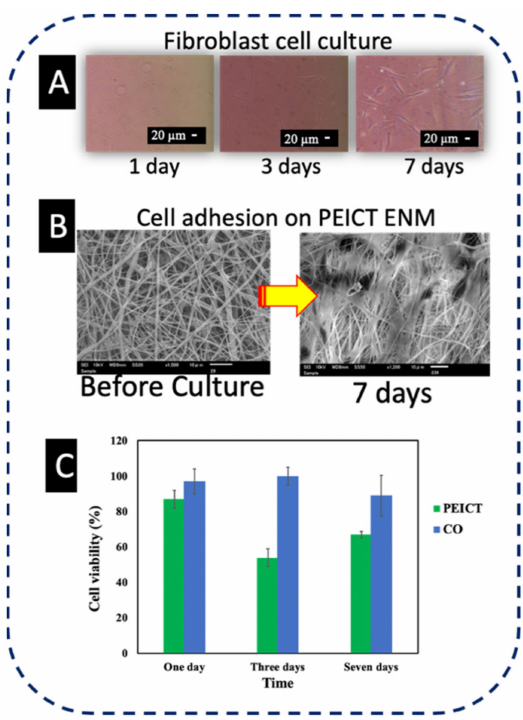
Figure 1. ( A ) Microscopic images of fibroblast cells in the culture flask. ( B ) SEM image of cell adhesion of PEICT ENM. ( C ) Cell viability of PEICT ENMs.